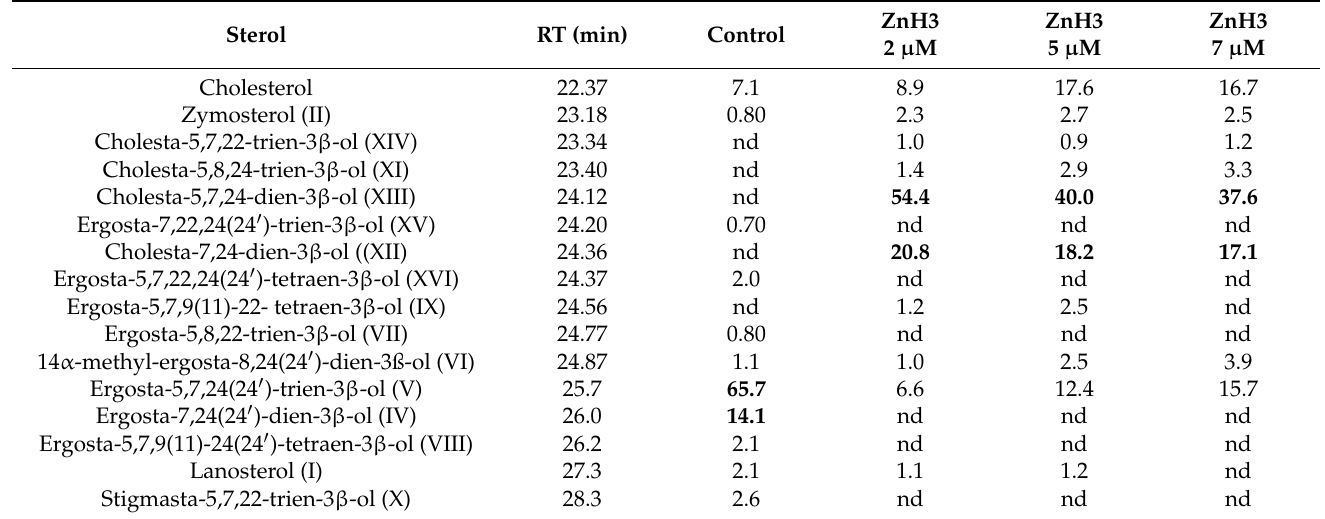
RT—retention time; nd—not detected. Sterol’s structure: see Figure